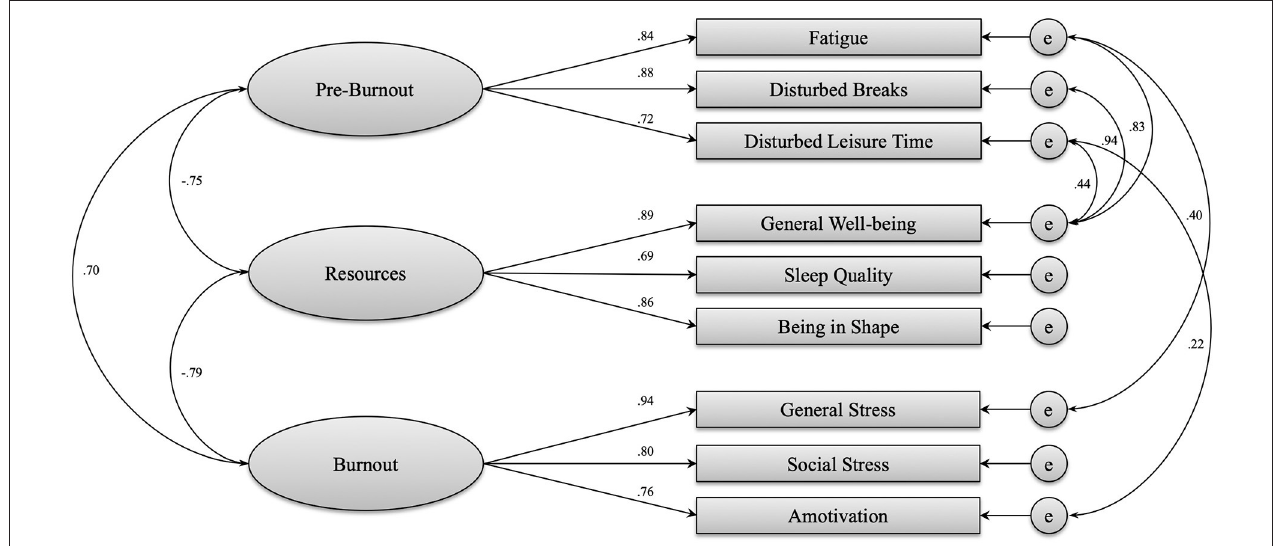
FIGURE 1 | Structural model of the BPQ-C scales ( χ 2 = 96.898, df = 19, p < 0.001, CFI = 0.973, SRMR = 0.044, RMSEA = 0.093, LO90 = 0.075, HI90 = 0.112).